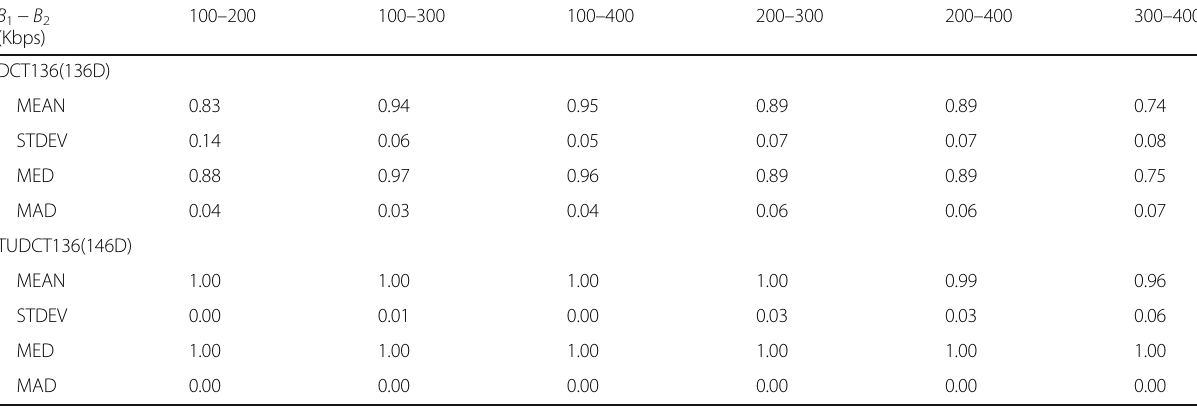
Table 6 Detection accuracy of the double compressed video fragments from its corresponding single compressed ones using DCT136 [11] feature and TUDCT136 feature on QCIF video